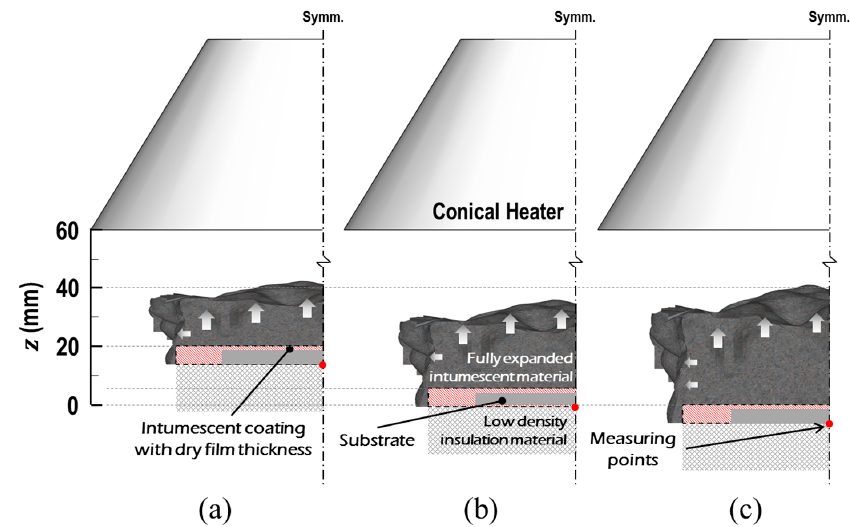
Figure 6. Initial setup of the specimen placement with a dry-film thickness of ( a ) 2 mm, ( b ) 3 mm, and ( c ) 4 mm.